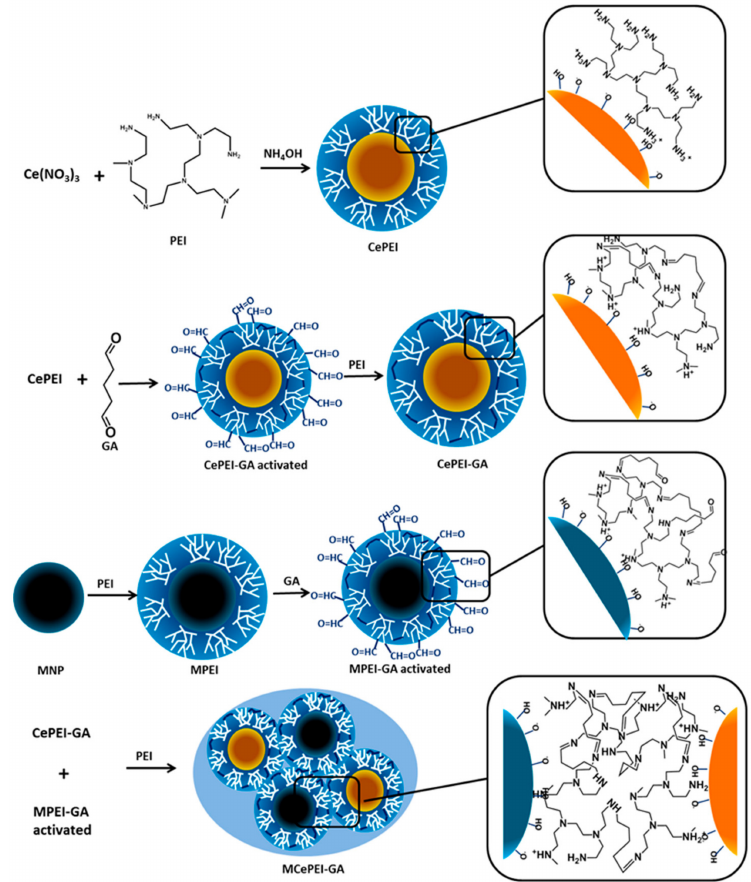
Figure 1. Schematic representation of nanoparticles